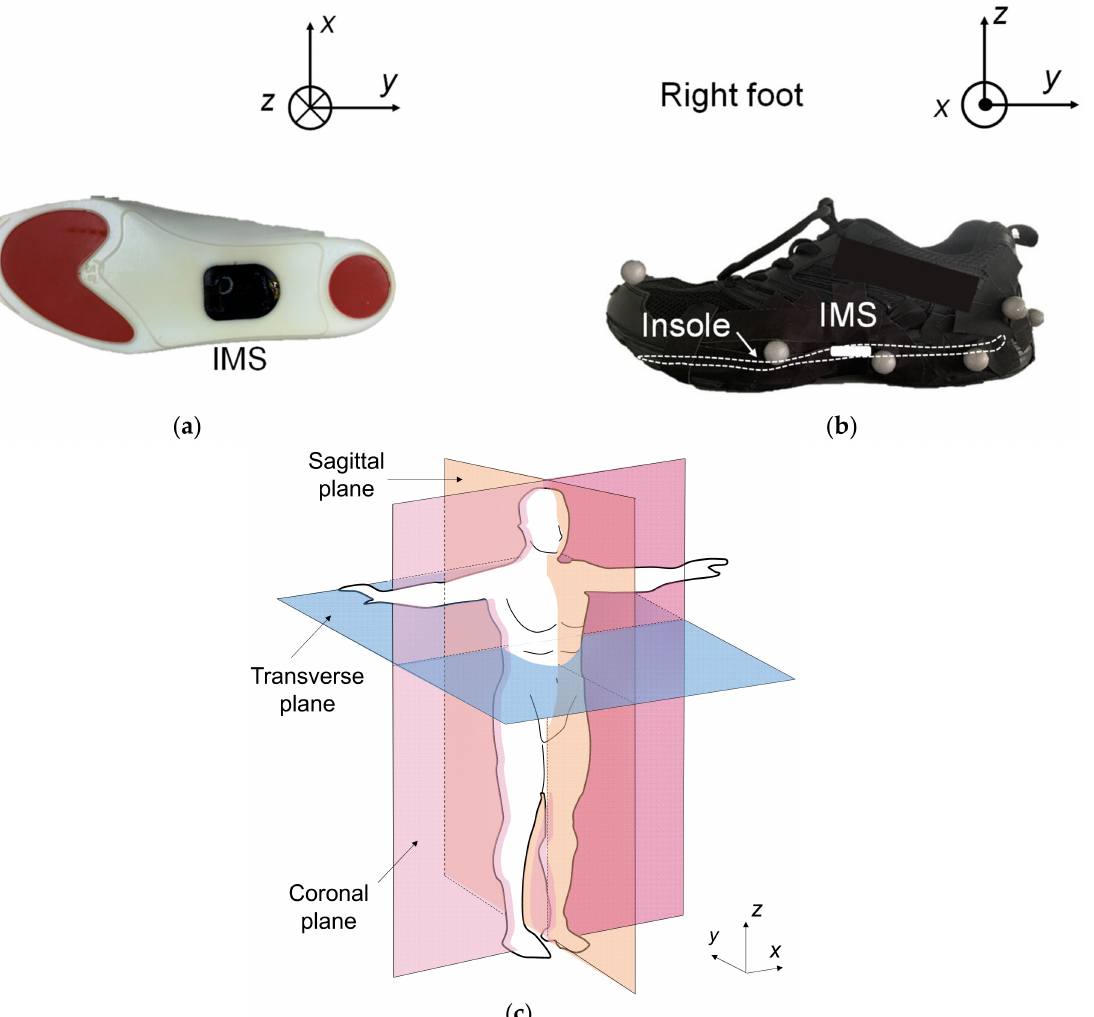
Figure 2. ( a ) Schematic of an IMS embedded in an insole. ( b ) Schematic of the insole inserted in an athletic shoe. ( c ) Definition of the coordinate axes and corresponding